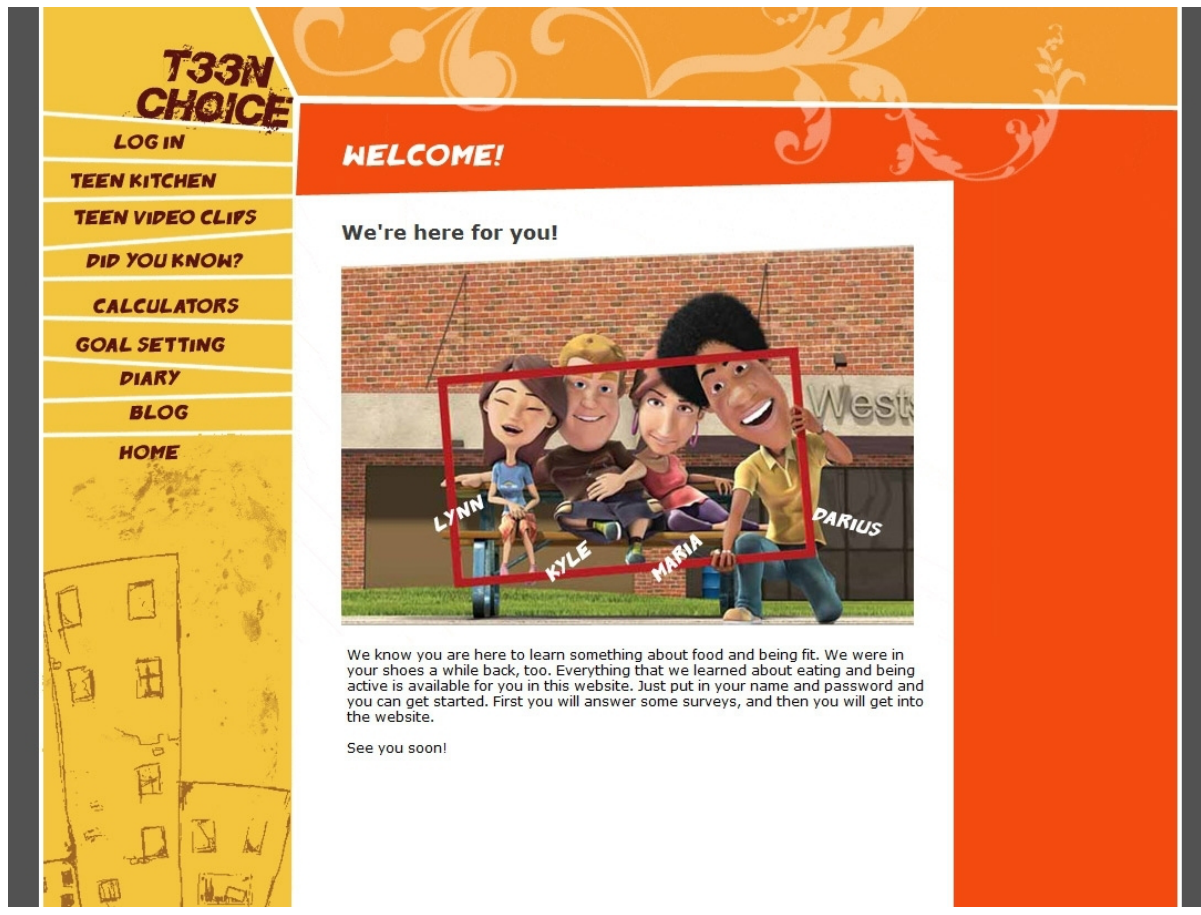
Figure 2. “Welcome” screenshot showing the online teen characters (ie, role